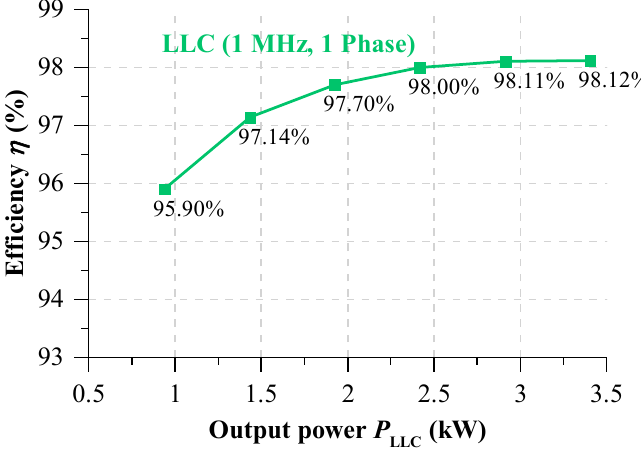
Figure 29. Measured efficiency of a single phase of the LLC resonant converter plotted versus the output power at 800 V battery voltage and driving of the primary inverter switches with a fixed 50% duty cycle.